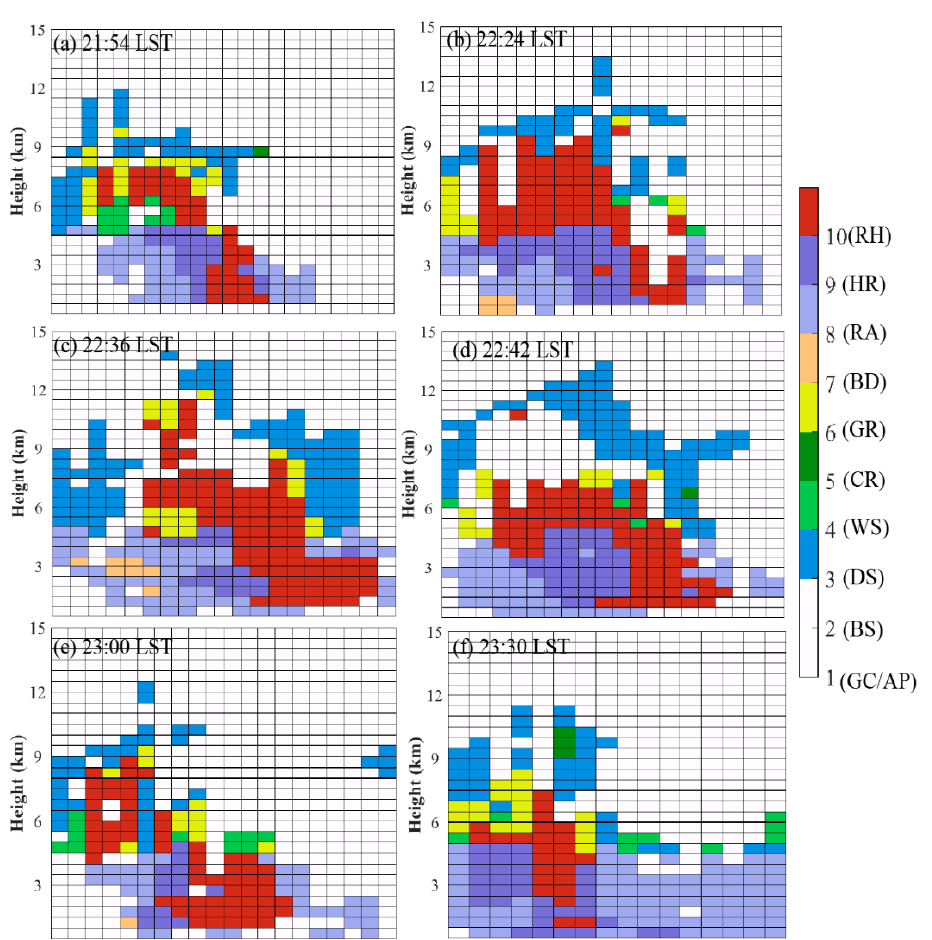
Figure 12. A to f represented phase profile. See Figure 11a1–a7 for the location of the section line. The direction of the section line is from bottom (A) to top (B).